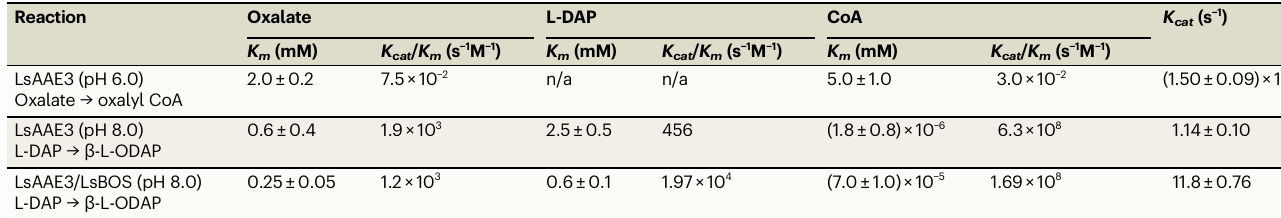
Table 2 | Kinetic parameters of LsAAE3 in the presence or absence of LsBOS Reaction